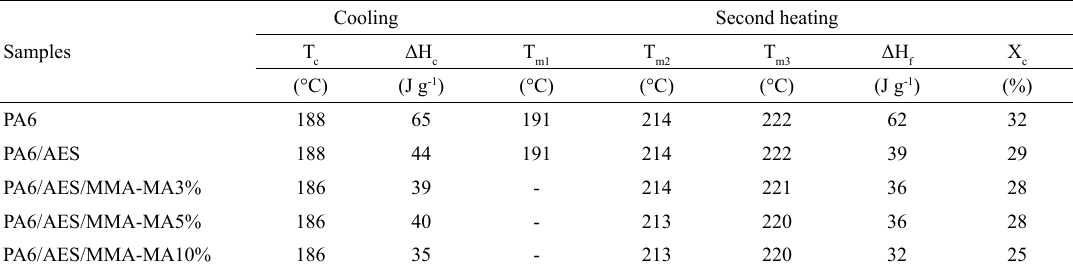
Table 2. Summary of DSC characteristic data of neat PA6, PA6/AES and blends compatibilized with MMA-MA synthetized with different MA contents. Samples